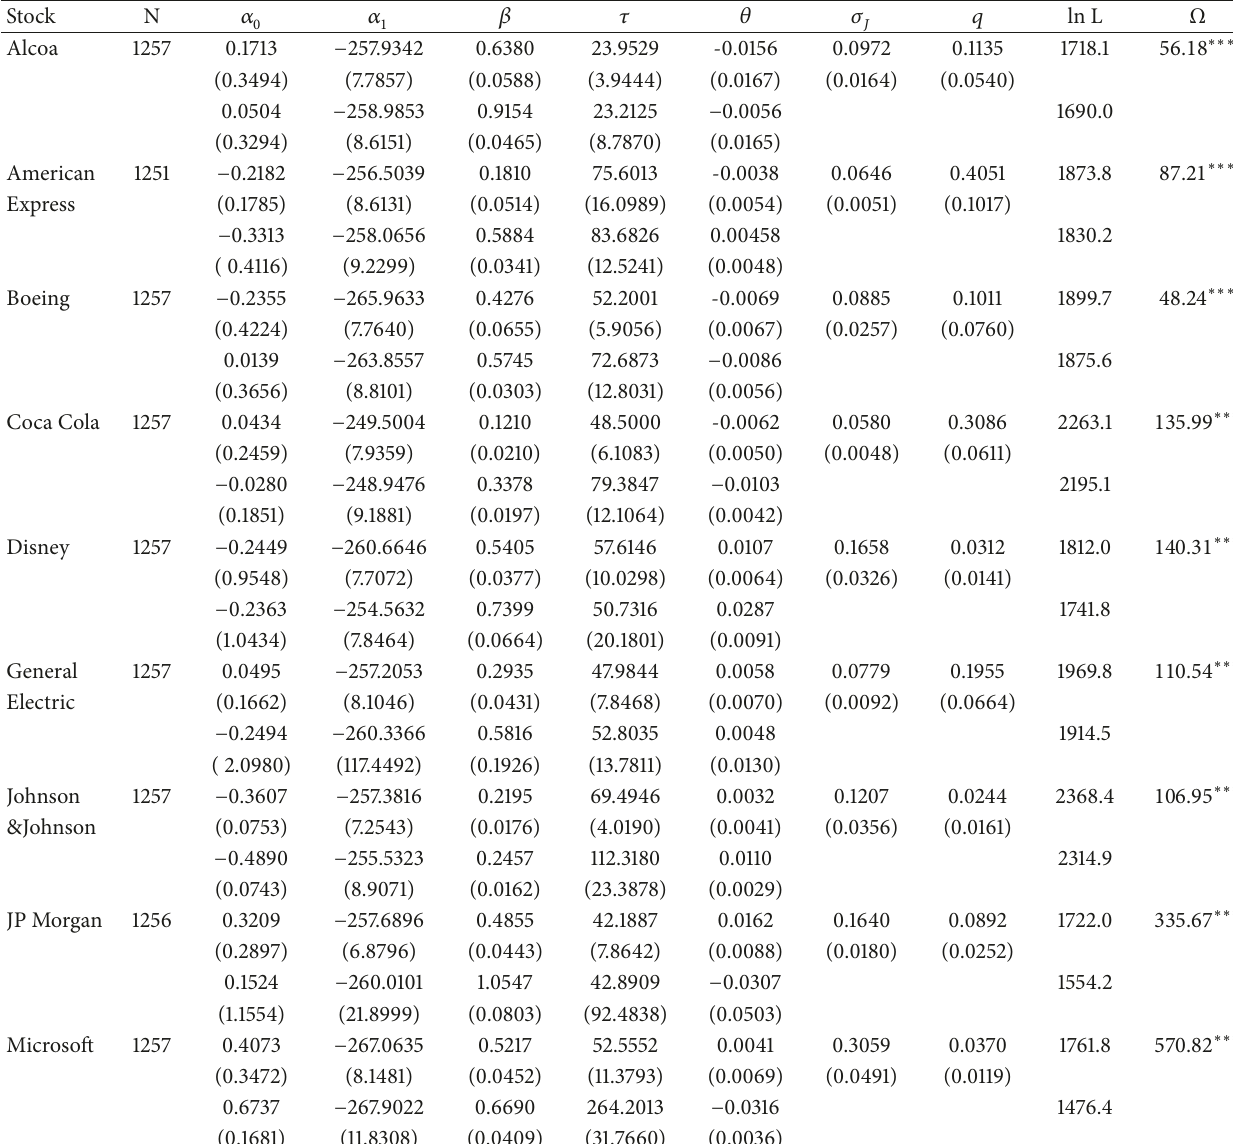
Figure 1: Daily closing stock price of Microsoft Corporation from January 25, 2000 to January 25, 2005. Table 3: Parameter estimates for